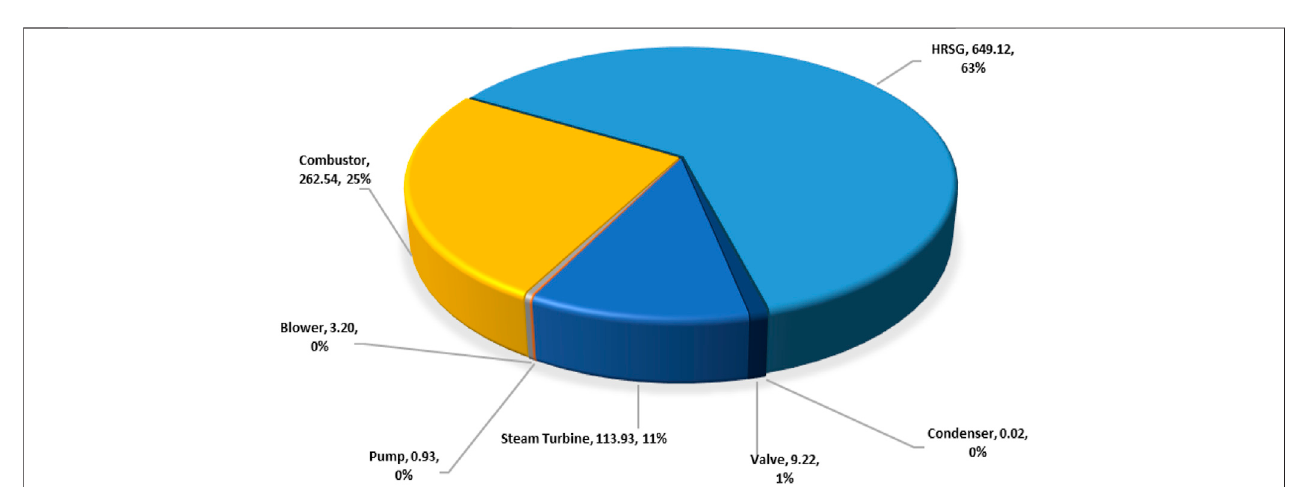
FIGURE 8 | Exergy destroyed in the steam power process.